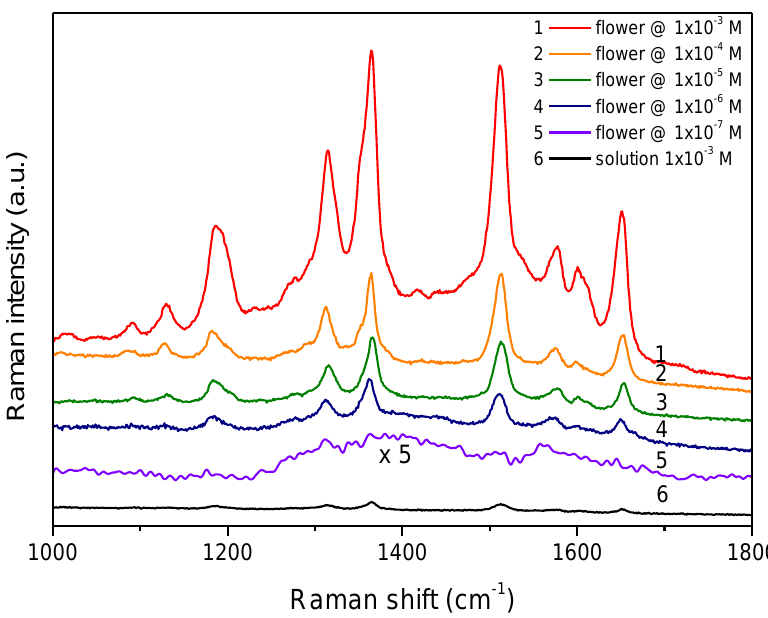
Figure 4. Spectra from silver roses, treated in R6G solutions of different concentration (1–5). Spectrum #6 is taken from the bulk of the 10 − 3 M R6G solution. Spectra correspond to the raw Raman signal and are not normalized to the solution concentration. SERS EF for different R6G vibrational modes, calculated according to Equations (3) and (4) for all concentrations, are listed in Table 1. In order to obtain stable fits, the intensity of the R6G spectral lines for samples, treated in the most diluted 10 − 7 M solution, were estimated by deconvolution of Lorentzian profiles with spectral positions and widths fixed to the corresponding values obtained for the 10 –6 M solution. The last row of the table lists the corresponding spectrum-average enhancement factor (SAEF) defined as I sol ( ν ) , where the sum runs over all detected vibrational modes. I SERS ( ν ) / ∑ SAEF = ∑ ν ν Each entry in the table is a statistical average calculated on a sample of at least three randomly chosen silver flowers. Table 1. The SERS EF for the silver flowers for different R6G modes as a function of the dilution order of the R6G solution. The corresponding spectrum-averaged enhancement factors (SAEF) are shown on the last row. The left and the right columns for each concentration correspond to the ‘n’ and ‘s’ flowers, respectively.